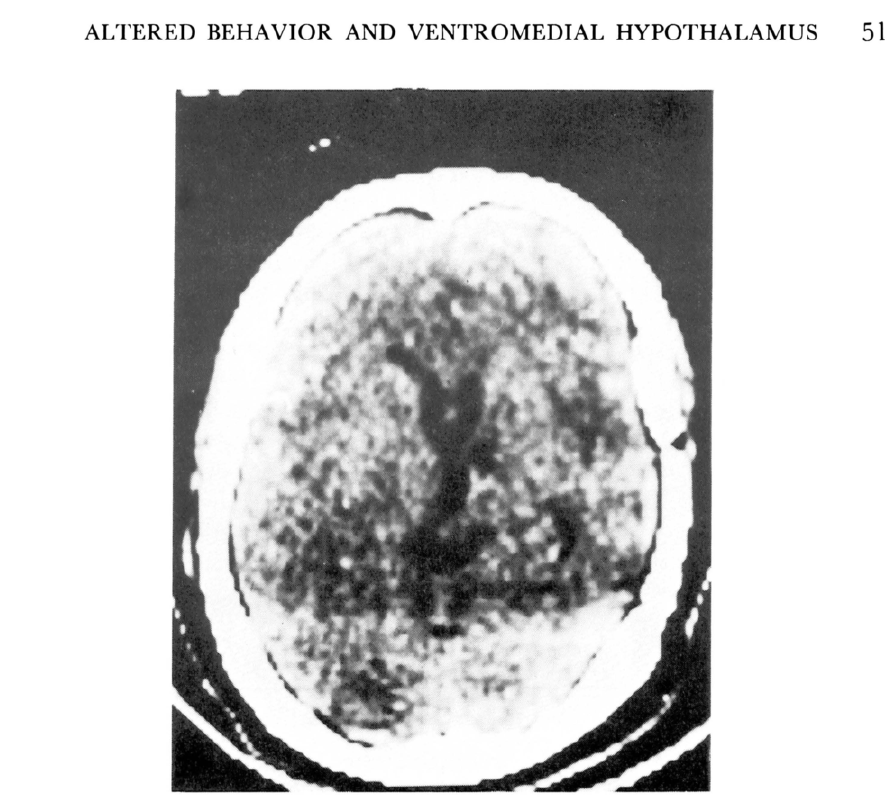
FIG. 1. Post-surgical CT scan demonstrates right temporal lobe and right hypothalamic defects with enlargement of the third